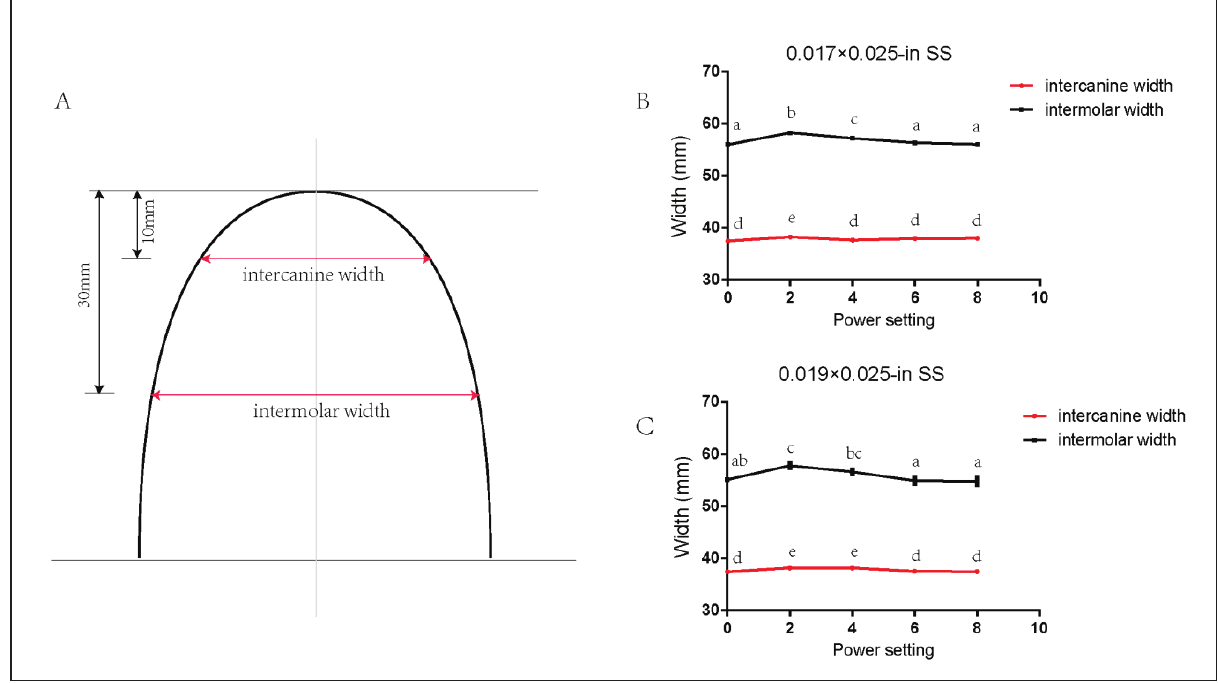
Fig. 7. Figure 7. (A) Schematic showing the intercanine width and the intermolar width. (B) Intercanine width and intermolar width of 0.017 × 0.025 inch unheated SS wire specimens and specimens heated at power settings of 2, 4, 6, and 8 for eight seconds. (C) Intercanine width and intermolar width of 0.019 × 0.025 inch unheated SS wire specimens and specimens heated at power settings of 2, 4, 6, and 8 for eight seconds. Bars with dissimilar letters indicate significantly different values ( p < 0.05). Each value is presented as the mean ± SD (N =